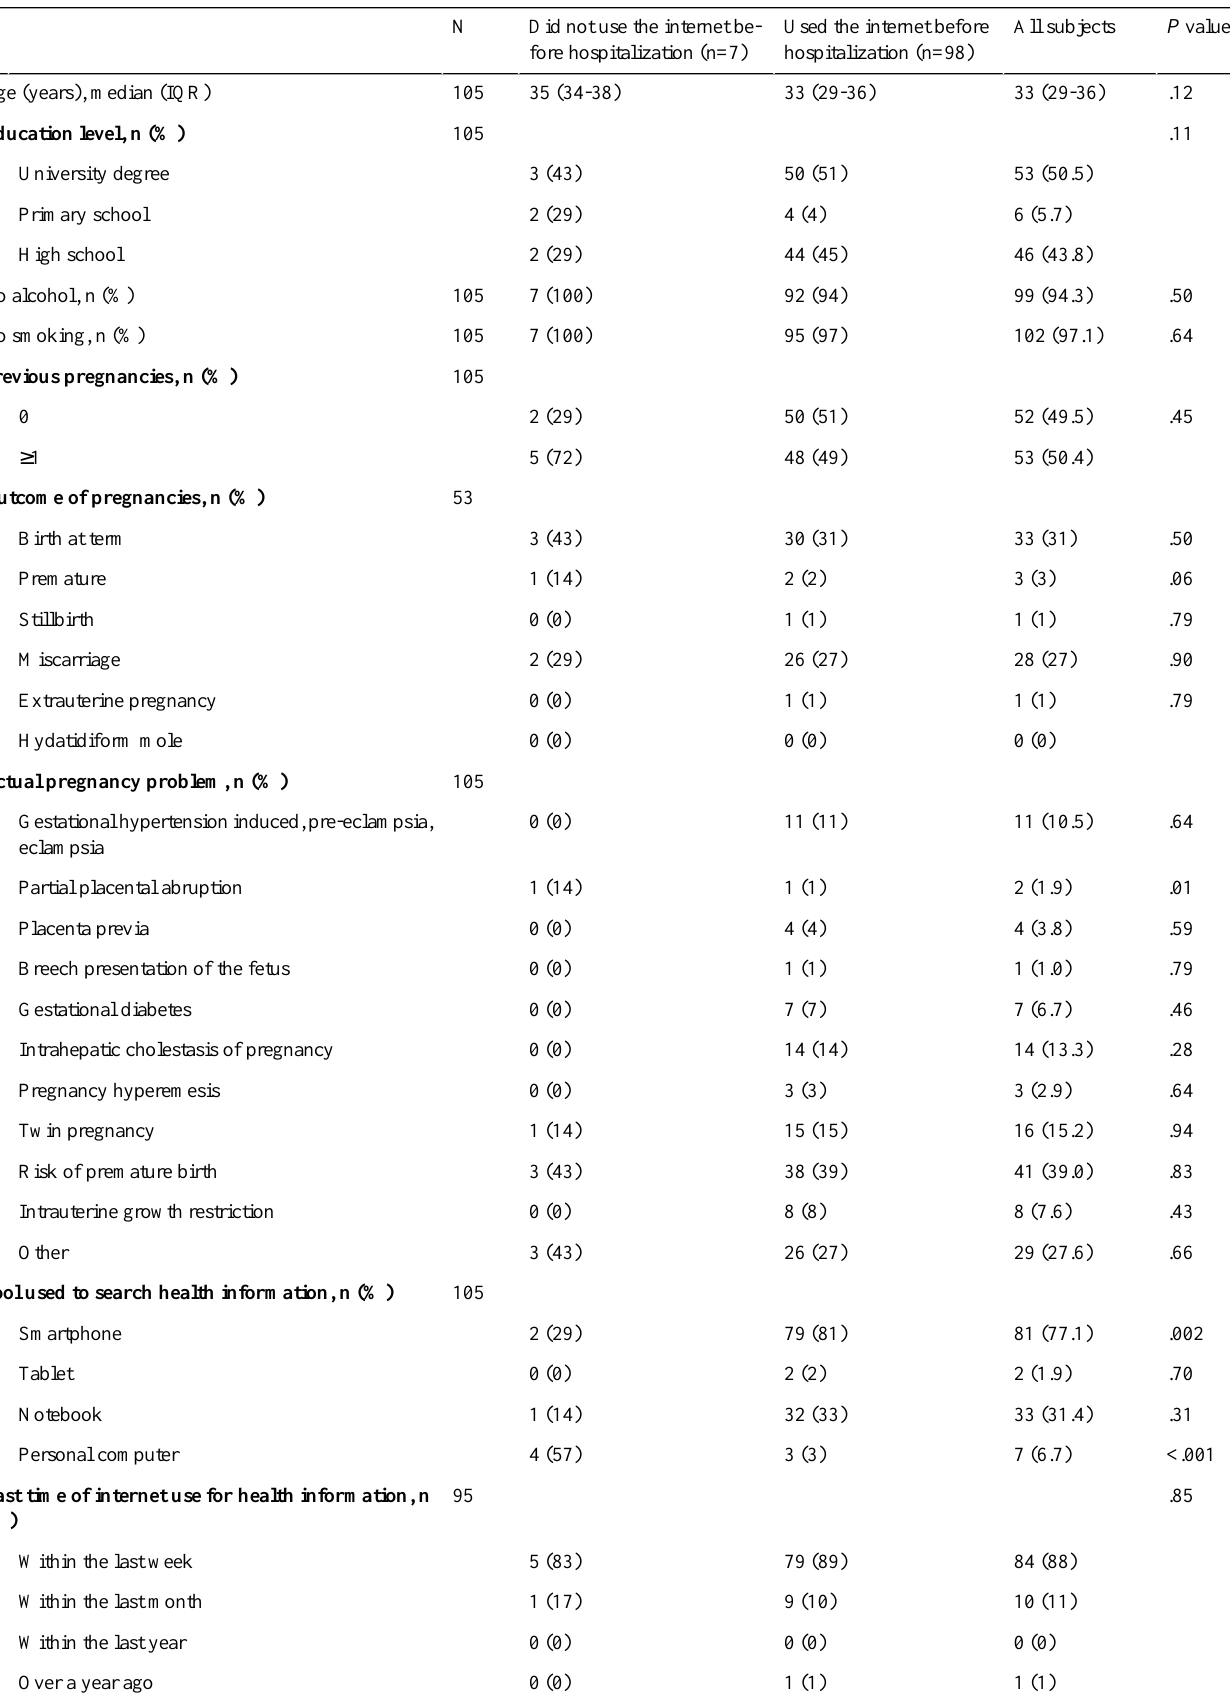
Table 1. Sample characteristics stratified by internet usage for seeking health-related information at home.